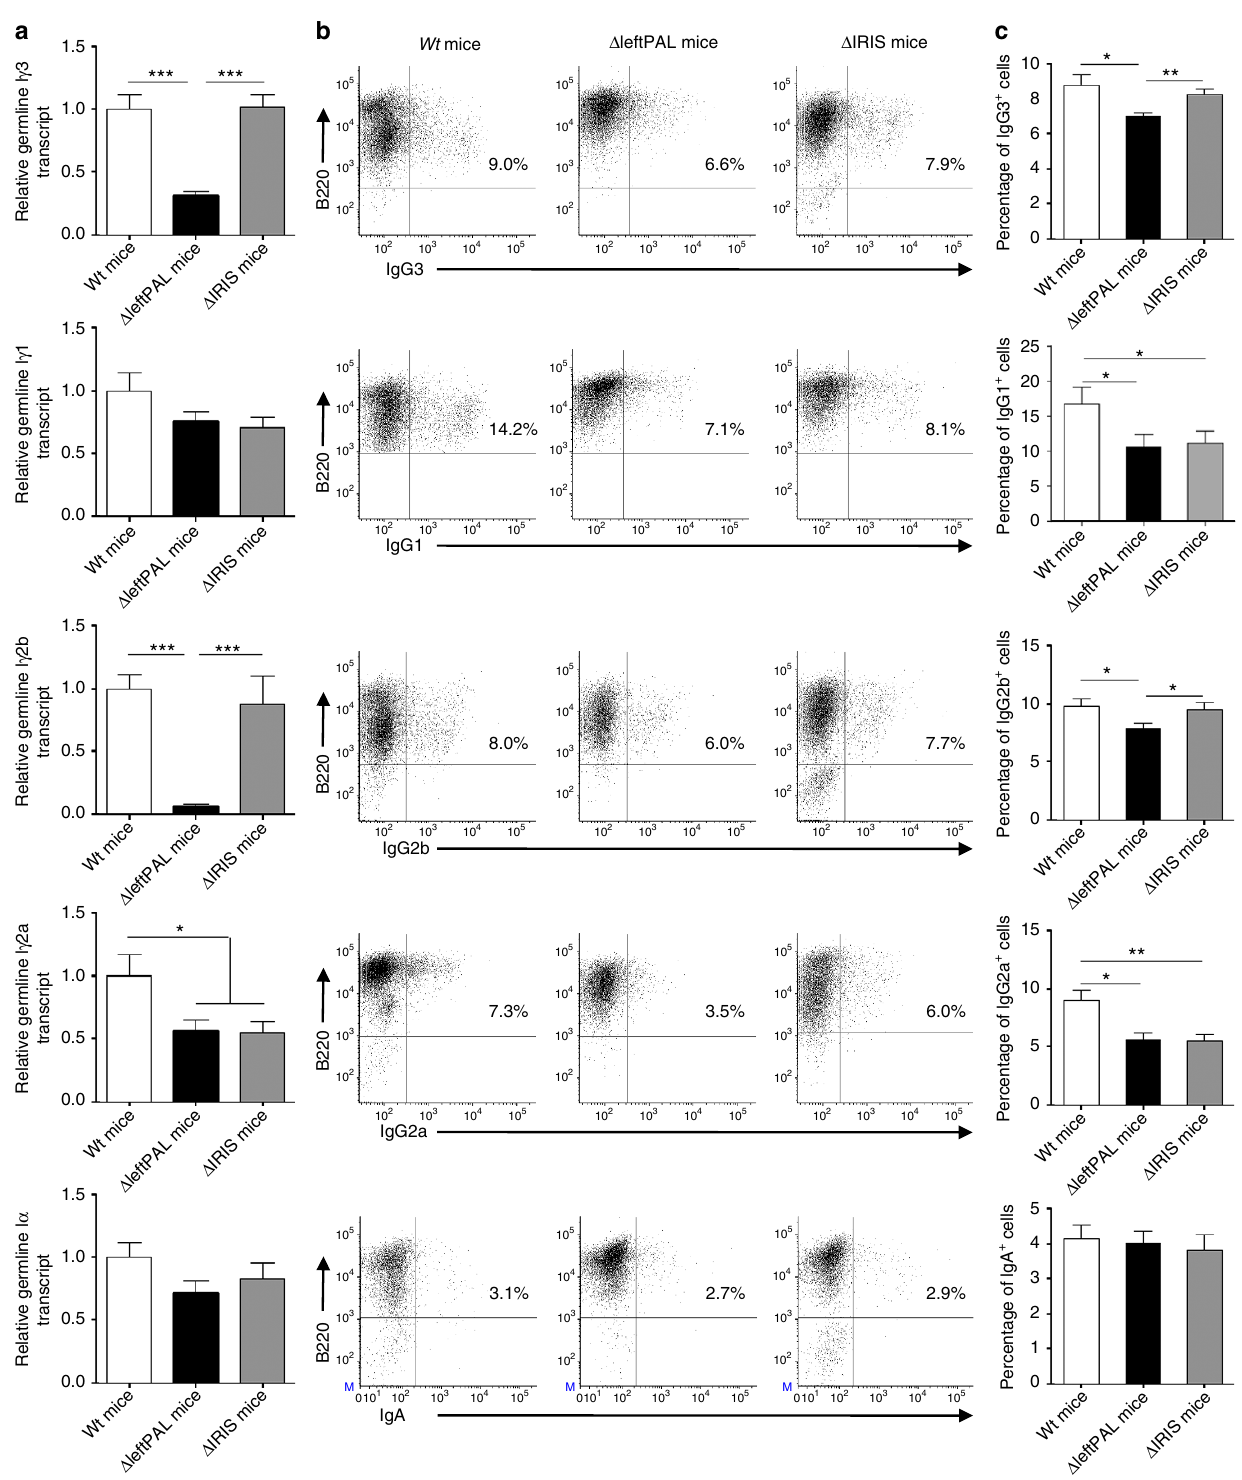
Figure 4 | Influence of the 3’RR palindrome on GLT and CSR. ( a ) GLT in B splenocytes of D leftPAL, D IRIS and wt mice. Cells were stimulated with LPS ± IL-4, INF g and TGF b for 2 days. I g 1 -C g 1 , I g 2a -C g 2a , I g 2b -C g 2b , I g 3 -C g 3 and I a -C a GL transcription was investigated by real-time PCR. Mean ± s.e.m. of six independent experiments with one mouse (8–12 weeks old, male and female). * P o 0.05 and *** P o 0.0001 (Mann–Whitney U -test for significance). Values were normalised to GAPDH transcripts. ( b ) CSR in B splenocytes of D leftPAL, D IRIS and wt mice. Cells were stimulated with LPS ± IL-4, INF g and TGF b for 3 days. Cells were then labelled with anti-B220-APC antibodies and anti-IgG 1 -, anti-IgG 2a -, anti-IgG 2b -, anti-IgG 3 - and anti-IgA-FITC antibodies. One representative experiment out of six (one mouse per experiment) is shown (8- to 12-week-old mice, male and female). ( c ) Mean ± s.e.m. of six independent experiments of CSR with one mouse (8–12 weeks old, male and female). * P o 0.05 and ** P o 0.001 (Mann–Whitney U -test for